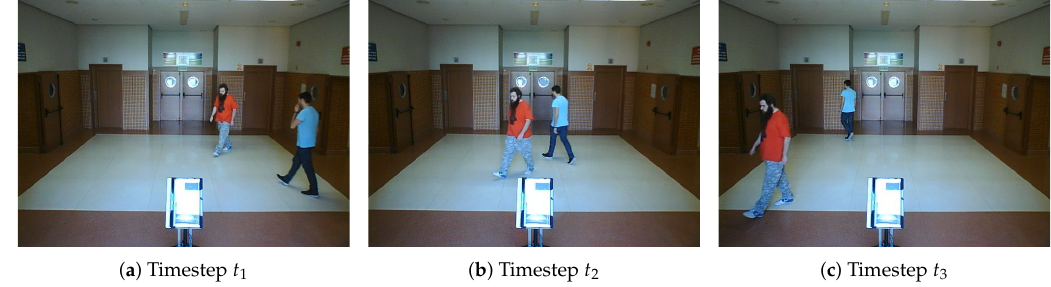
Figure 14. Real scenario 2—Images sequence.